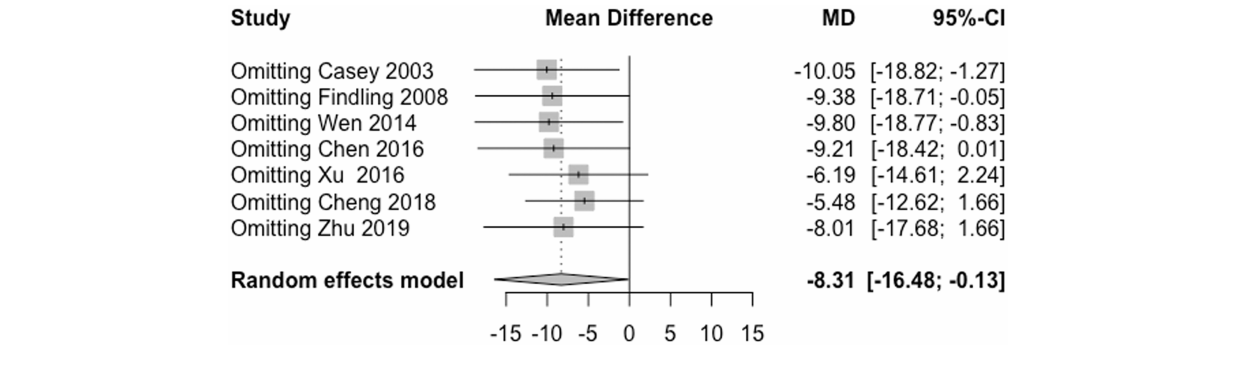
FIGURE 8 | Sensitivity